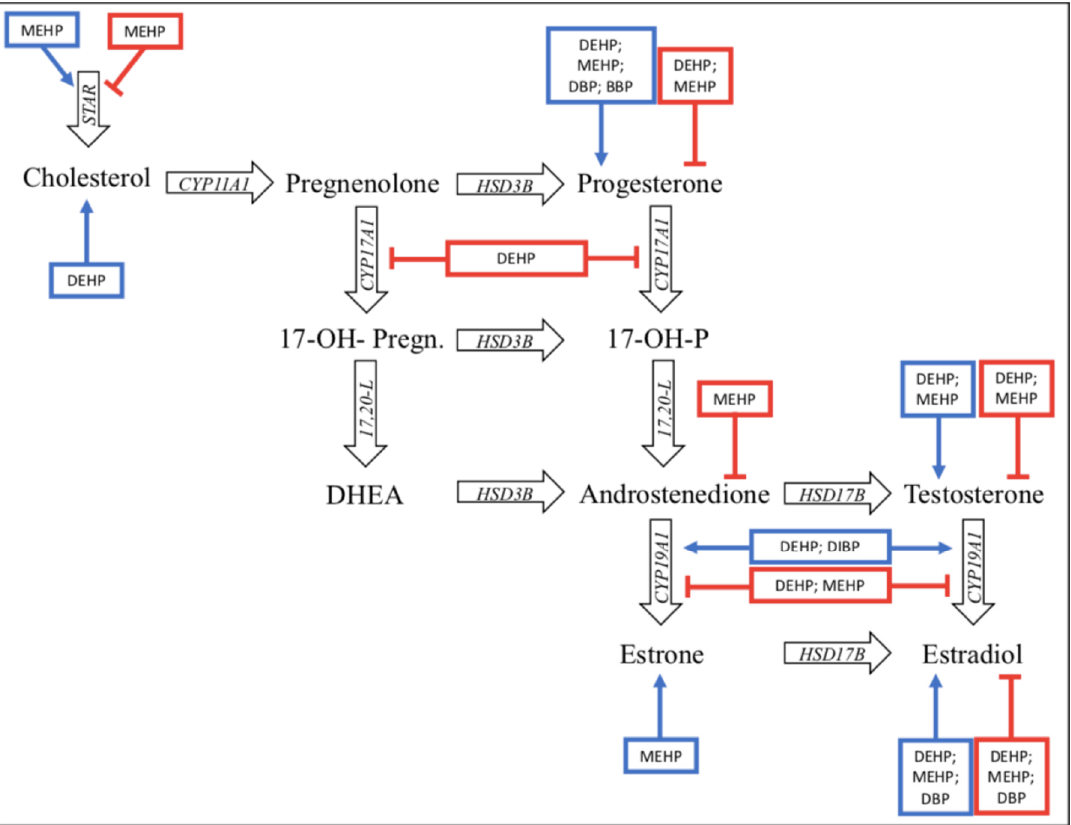
Figure 2. The major findings on the effects of phthalates on steroidogenesis are summarized. The phthalates metabolites modify the concentration of hormones and steroidogenic enzymes. Those in blue boxes increase the level of the hor- mone/steroidogenic enzyme indicated in black, while those in red boxes decrease the levels of the hormones/steroidogenic enzyme highlighted. [55].